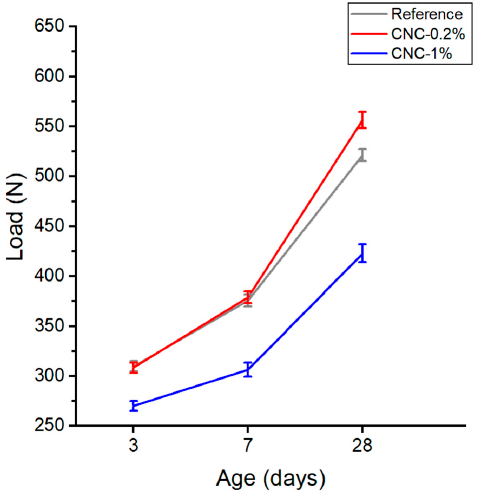
Figure 5. Average of the peak load at 3, 7, and 28 days.